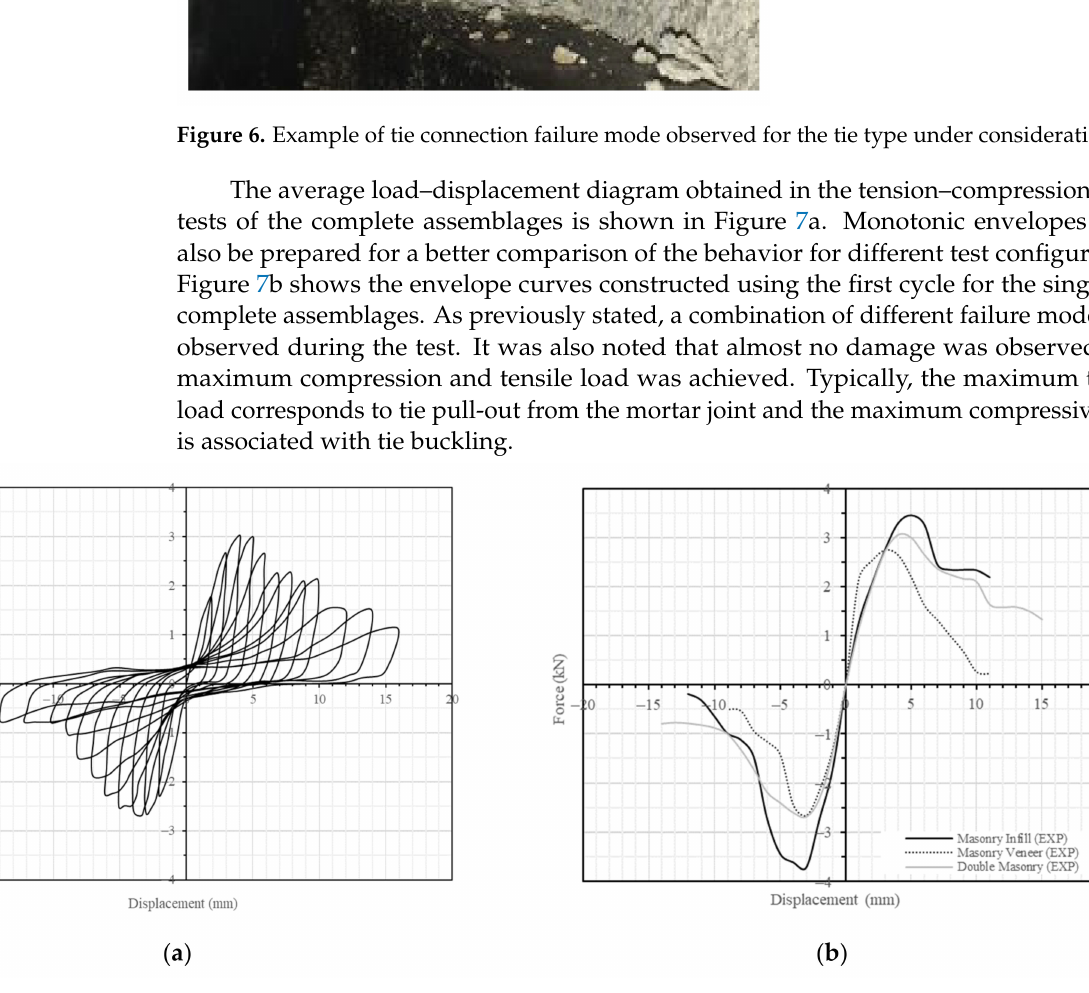
Figure 7. Results from tension–compression tests: ( a ) force-displacement diagram of complete assemblage specimen; ( b ) envelope curves from cyclic tests